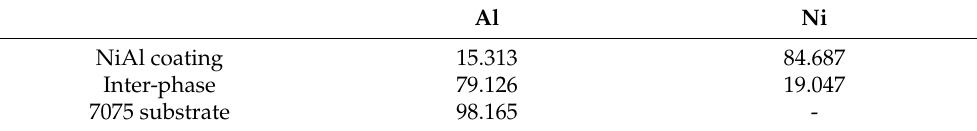
Figure 12. Metallurgical bonding at NiAl/7075 interface: ( a ) Cross section of plasma wire sprayed NiAl coating on 7075 substrate, ( b ) Magnified observation of the square zone of ( a ), ( c ) Further enlarged observation of the eutectic phase. Table 6. Atom ratio (Avg. at. %) of NiAl coating, 7075 substrate and the inter-phase in Figure 12b.